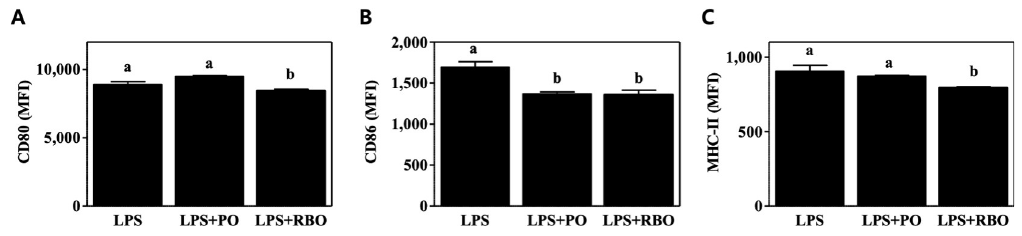
Fig 4. Expression of activation markers on the surface of LPS-stimulated RAW 264.7 macrophages. Cells were stained with fluorescence-conjugated mAbs specific to (A) CD80, (B) CD86, or (C) MHC-II, and flow cytometric quantification was performed. Data are presented as mean ± SEM (n = 7–8) of arbitrary units of mean fluorescence intensity (MFI). Values with different letters are statistically significant at p < 0.05 within the panel. (PO, palm oil; RBO, rice bran oil).